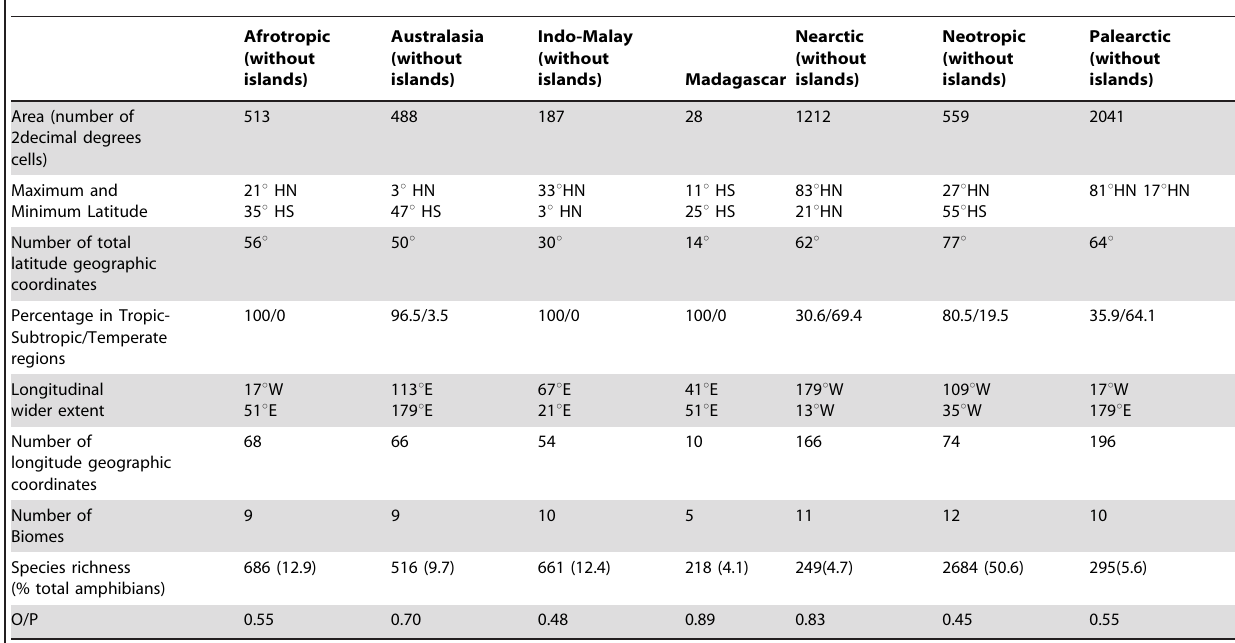
Table 1. Geography, richness and equilibrium descriptions across biogeographical regions.